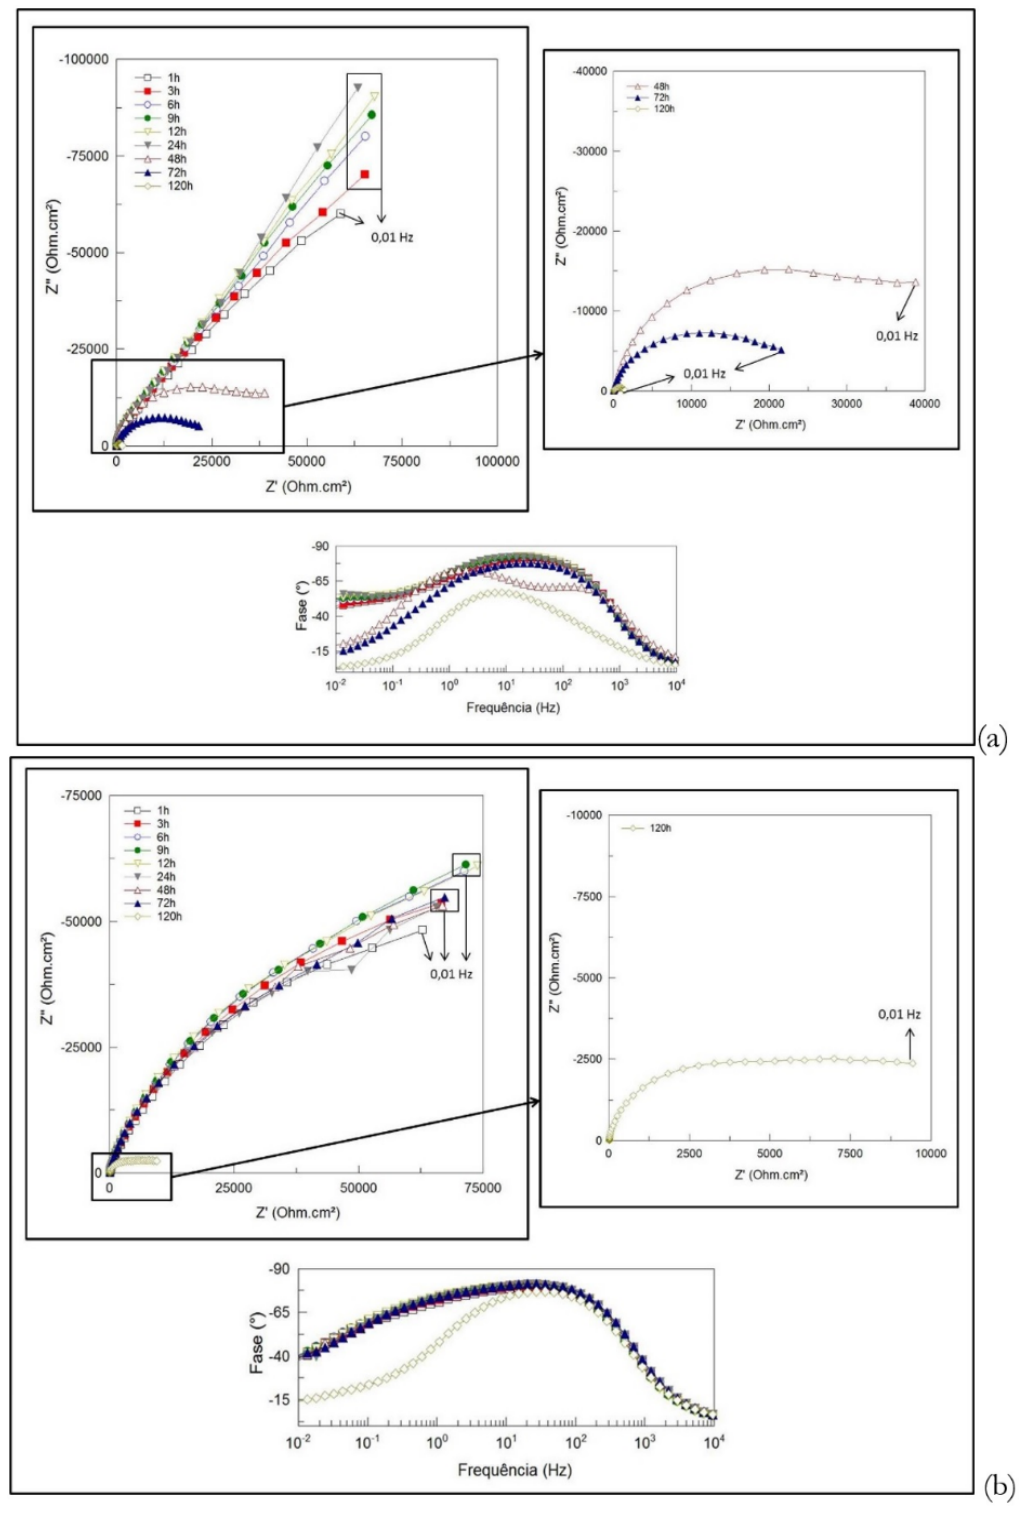
Figure 4. Nyquist and phase angle diagrams (φ versus log f) with immersion time for CA -50 steel in pore water: (a) AP1 + 1.0% NaCl (common Portland cement [17]). (b) AP2 + 1.0% NaCl (blast furnace slag [17]). (c) 75CPV25EA + 1.0% NaCl (steel slag